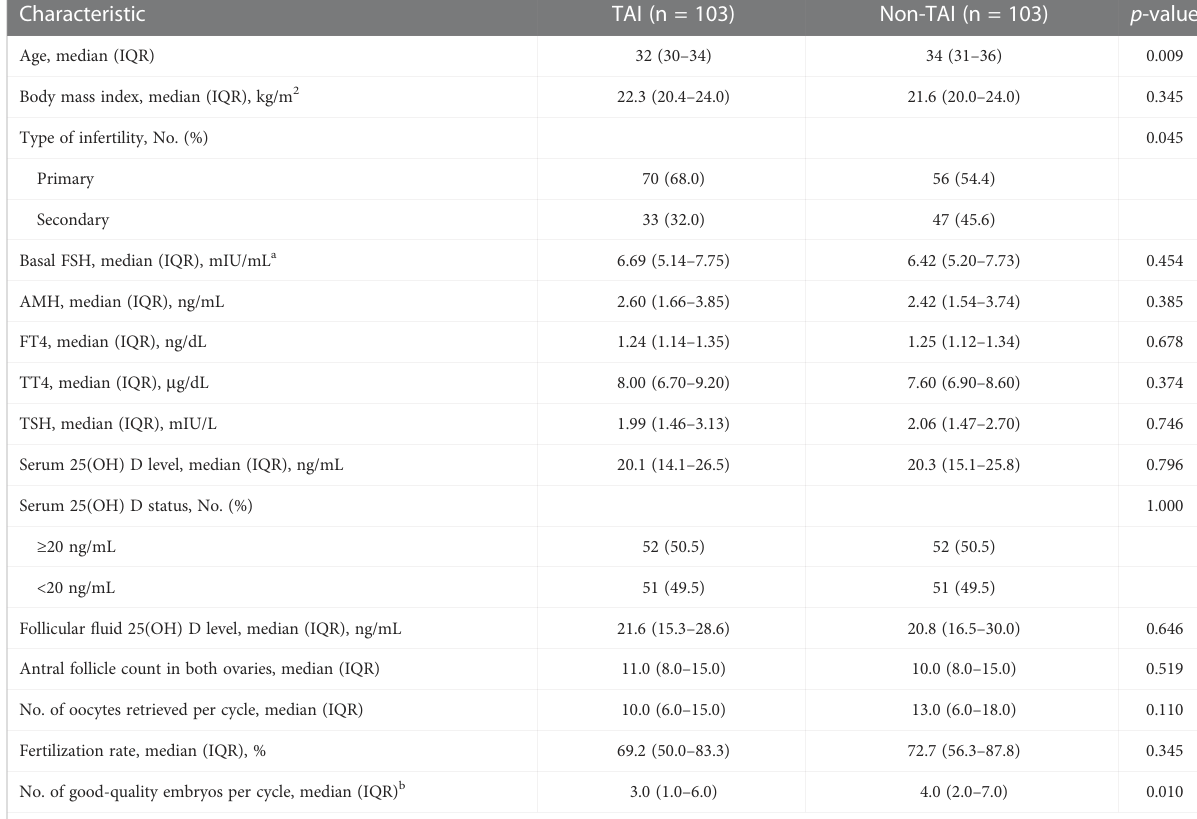
TABLE 1 Baseline characteristics and in vitro fertilization data of patients based on TAI and non-TAI.